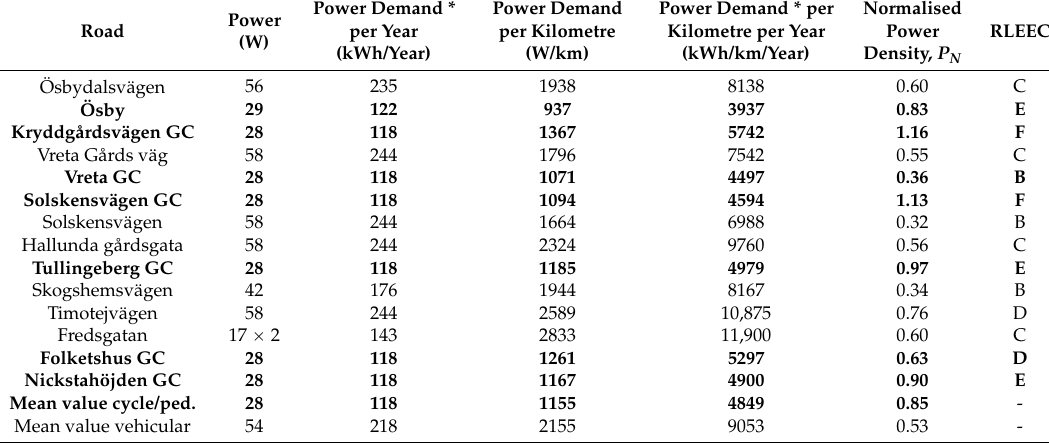
GC, pedestrian and bicycle roads; ped., pedestrian.